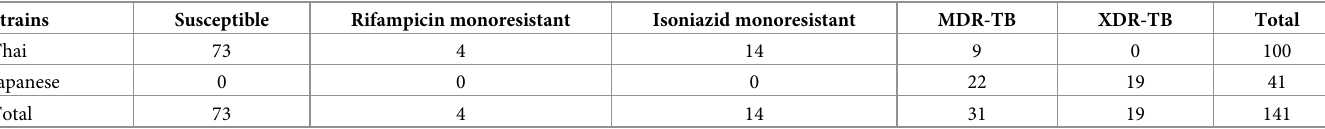
Table 3. Phenotypic drug susceptibility testing.